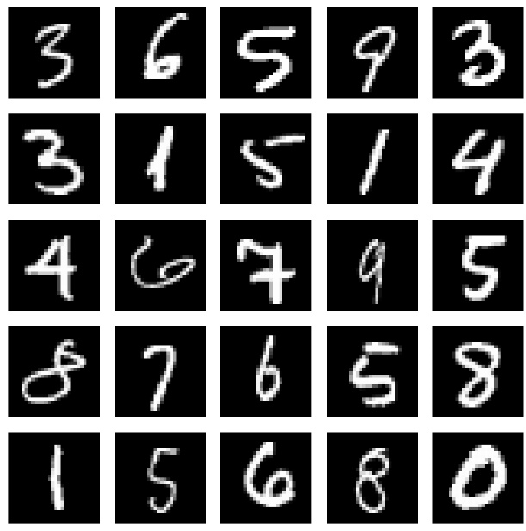
Figure 4. MNIST dataset example.